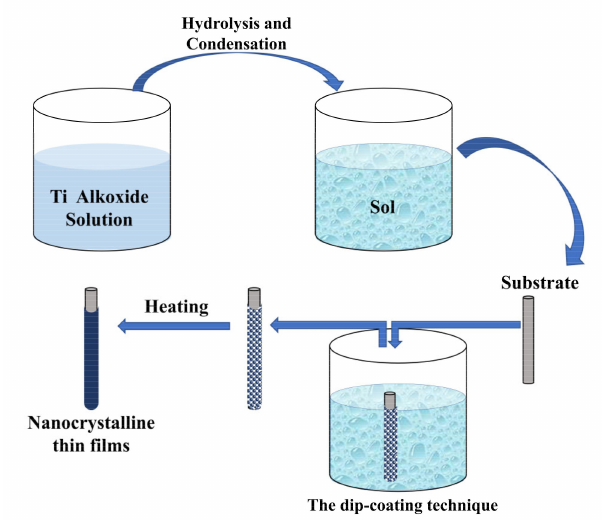
Figure 2. Sol-gel process for obtaining TiO 2 thin films. The process begins with the formation of the sol by hydrolysis and condensation of titanium alkoxides mixed with alcohol and catalytic agents. After the deposition, by dip-coating, the film is formed. Next, a thermal treatment is used for the preparation of nanocrystalline thin films.